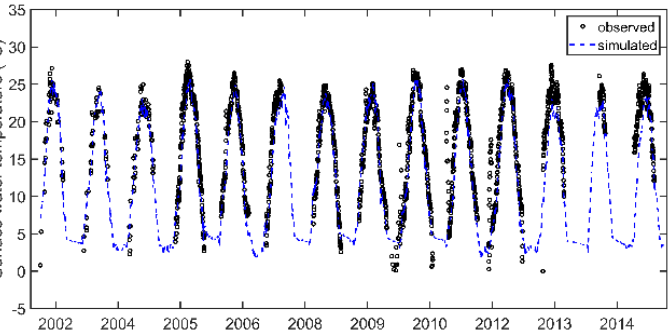
Figure 3. The simulated and observed surface water temperature comparison at Sta. 45005 (ECCC & NOAA) for 2002–2015.